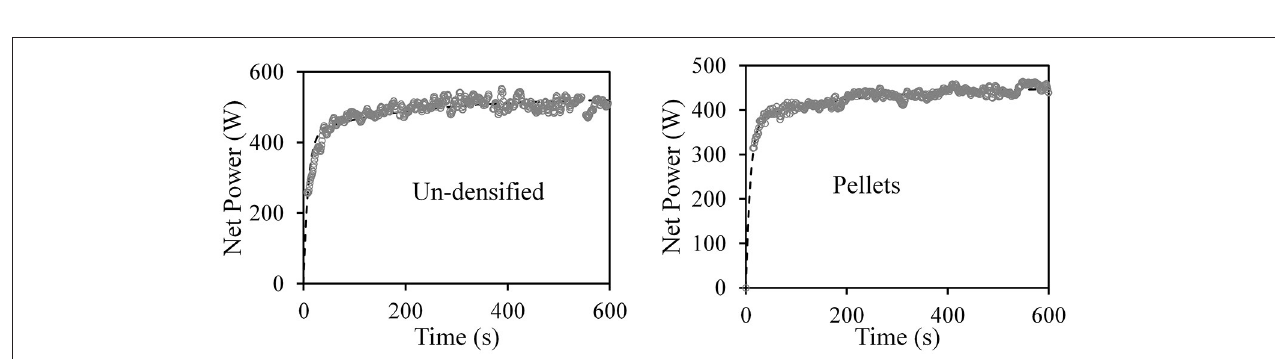
FIGURE 5 | Symbols—measured net power vs. time of 200g samples during grinding of torrefied CE, un-densified material and pellets. Dashed lines, fits of net power to Equation (12) for the short characteristic time, τ 1 = 9.2s; and characteristic time τ 2 = 203.0s.